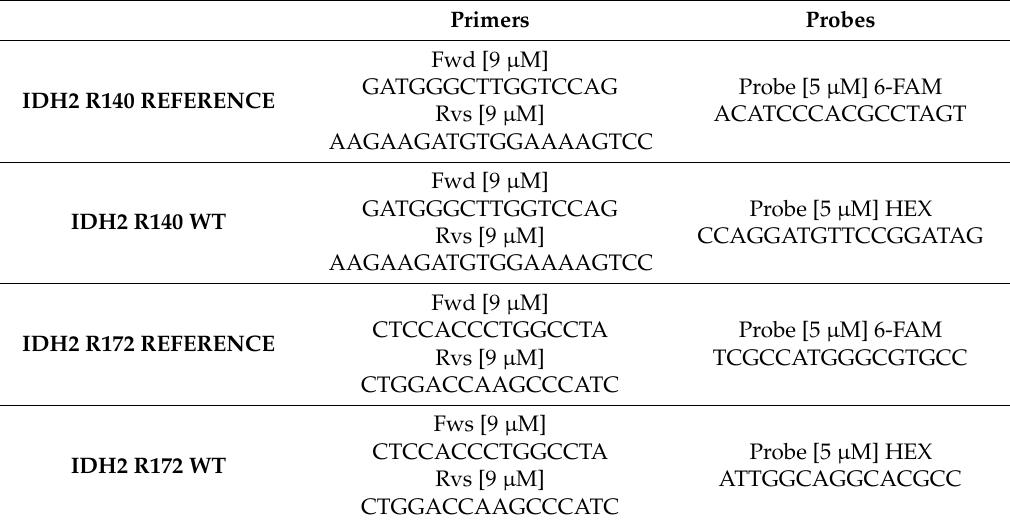
Table 7. Drop o ff ddPCR primers and probes